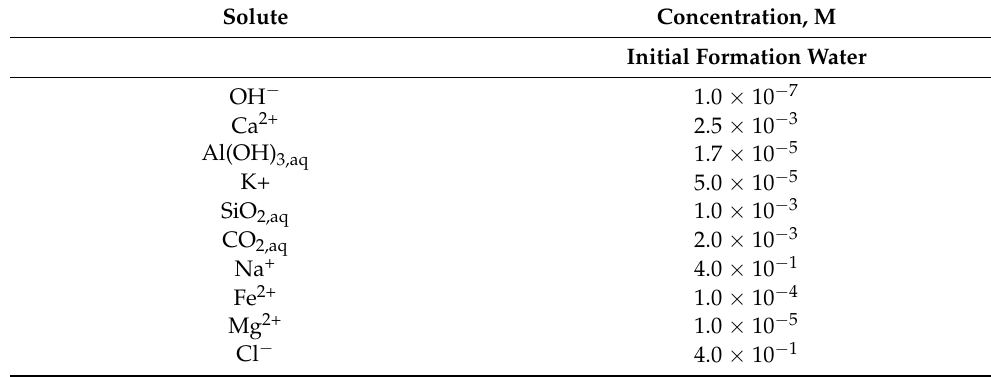
Table 6. The initial and boundary formation water